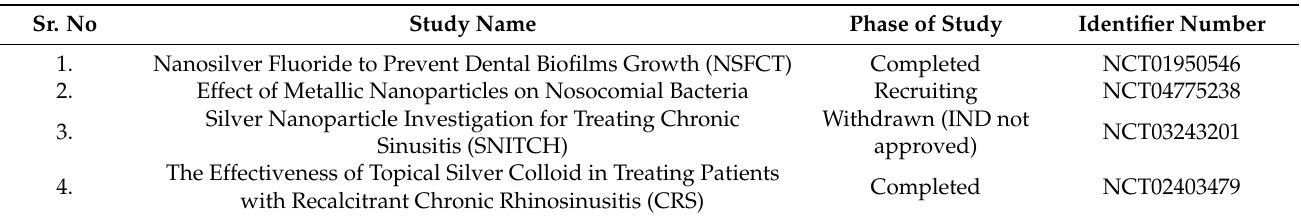
Table 4. Selected studies of NP’s mode of action against Gram-positive and Gram-negative